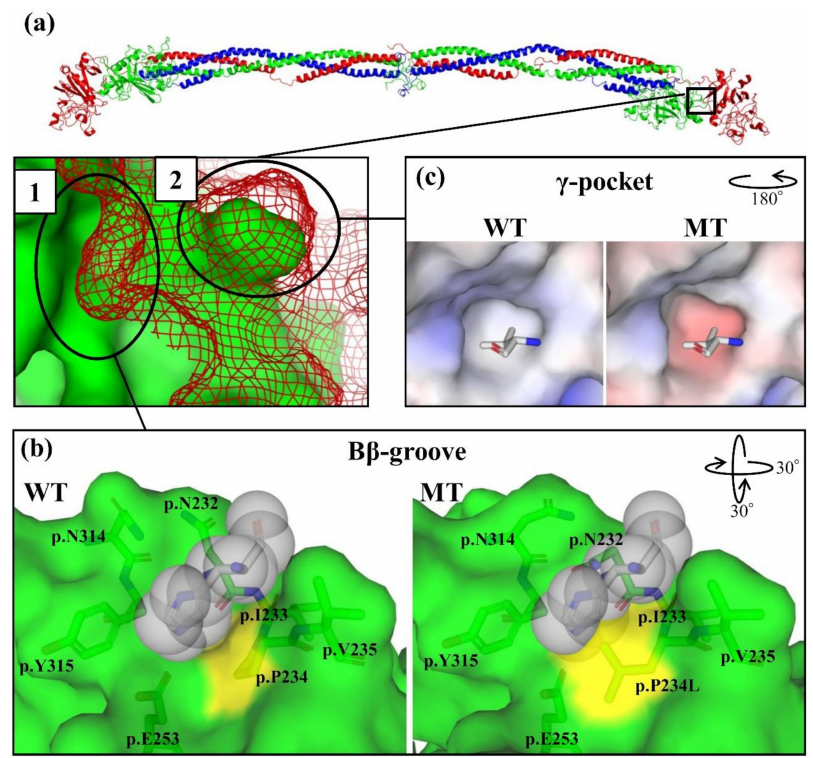
Figure 6. The impacts on each chain structure of mutations. Panel ( a ) (upper side) shows the